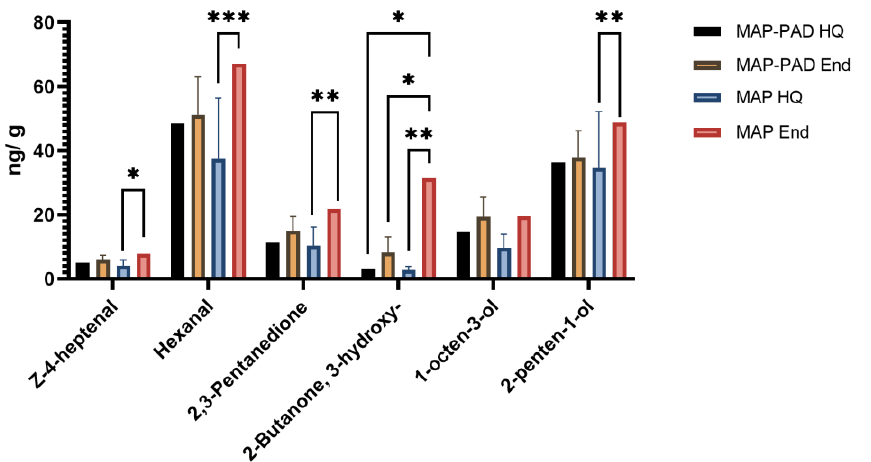
Figure 4. Concentration (ng/g) of target compounds identified via HS-SPME-GC-MS analysis in seabream fillets, packed in active packaging with (MAP-PAD) or without (MAP) a pad, at the high quality (HQ) time point or the end of high-quality (End) shelf-life. (*) stands for p < 0.05; (**) stands for p < 0.01; (***) stands for p < 0.001.